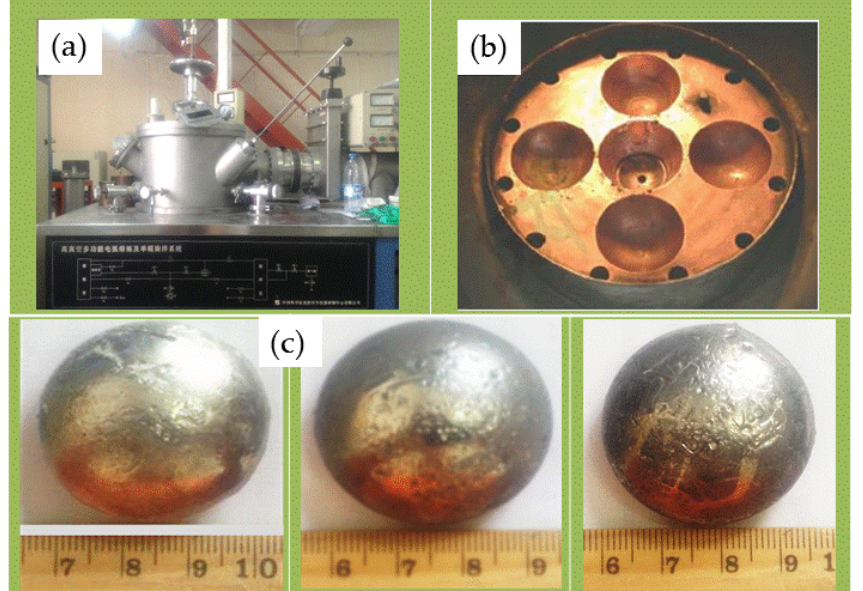
Figure 1. Schematic diagram of material preparation process: ( a ) High vacuum multifunctional arc melting and single-roll spin quenching system; ( b ) Water-cooled copper crucible-smelting tank; ( c ) Button material after smelting.